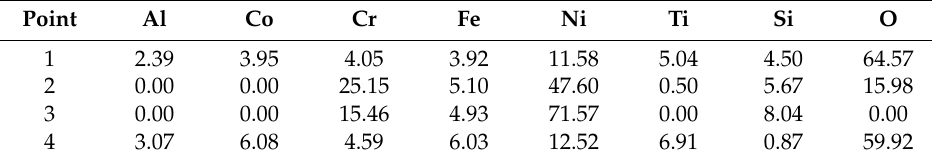
Figure 7. Worn surfaces of HEA/Ni60 coating and counterpart at 25 ◦ C ( a – c ) and 500 ◦ C ( d – f ). Table 3. Energy dispersive spectroscopy analysis results of typical points in Figure 7 (at